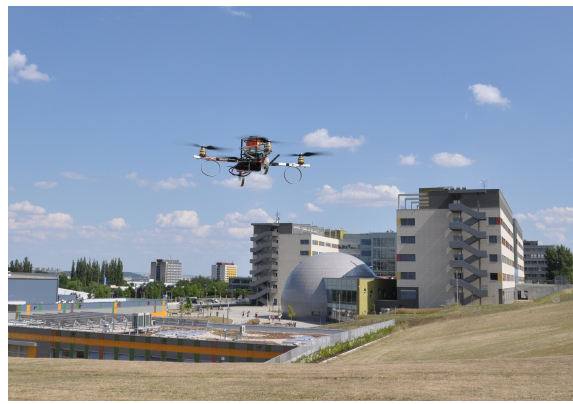
Figure 1. Uranus UAV during a